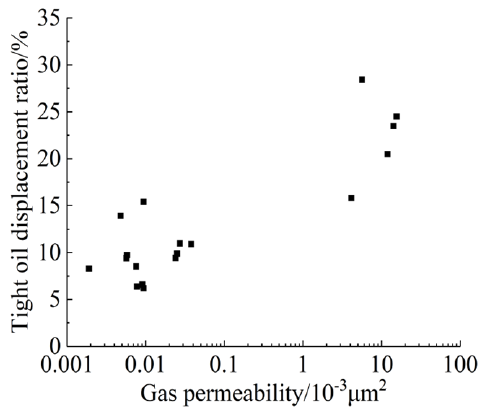
Figure 9. The relationship between permeability and tight oil displacement ratio.